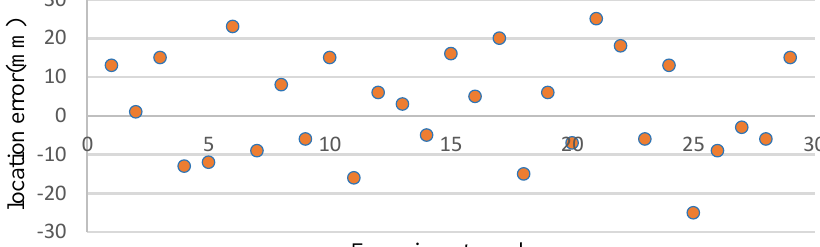
Figure 17. Location